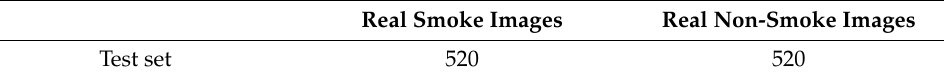
Table 3. Testing set.